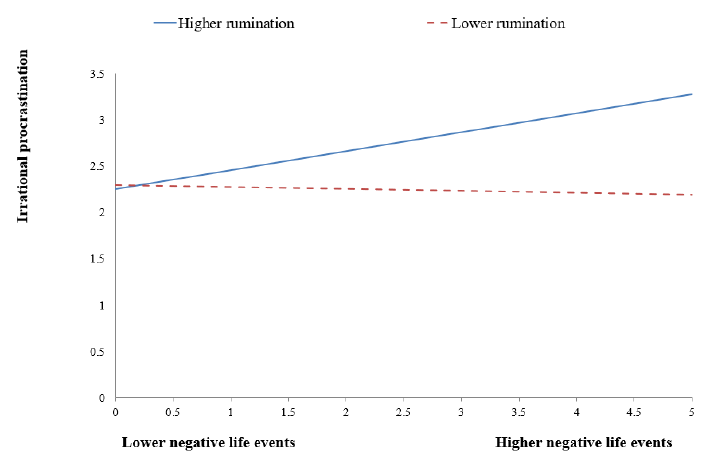
Figure 4. Rumination moderates the regression coefficient of negative life events on procrastination in the sample of females.